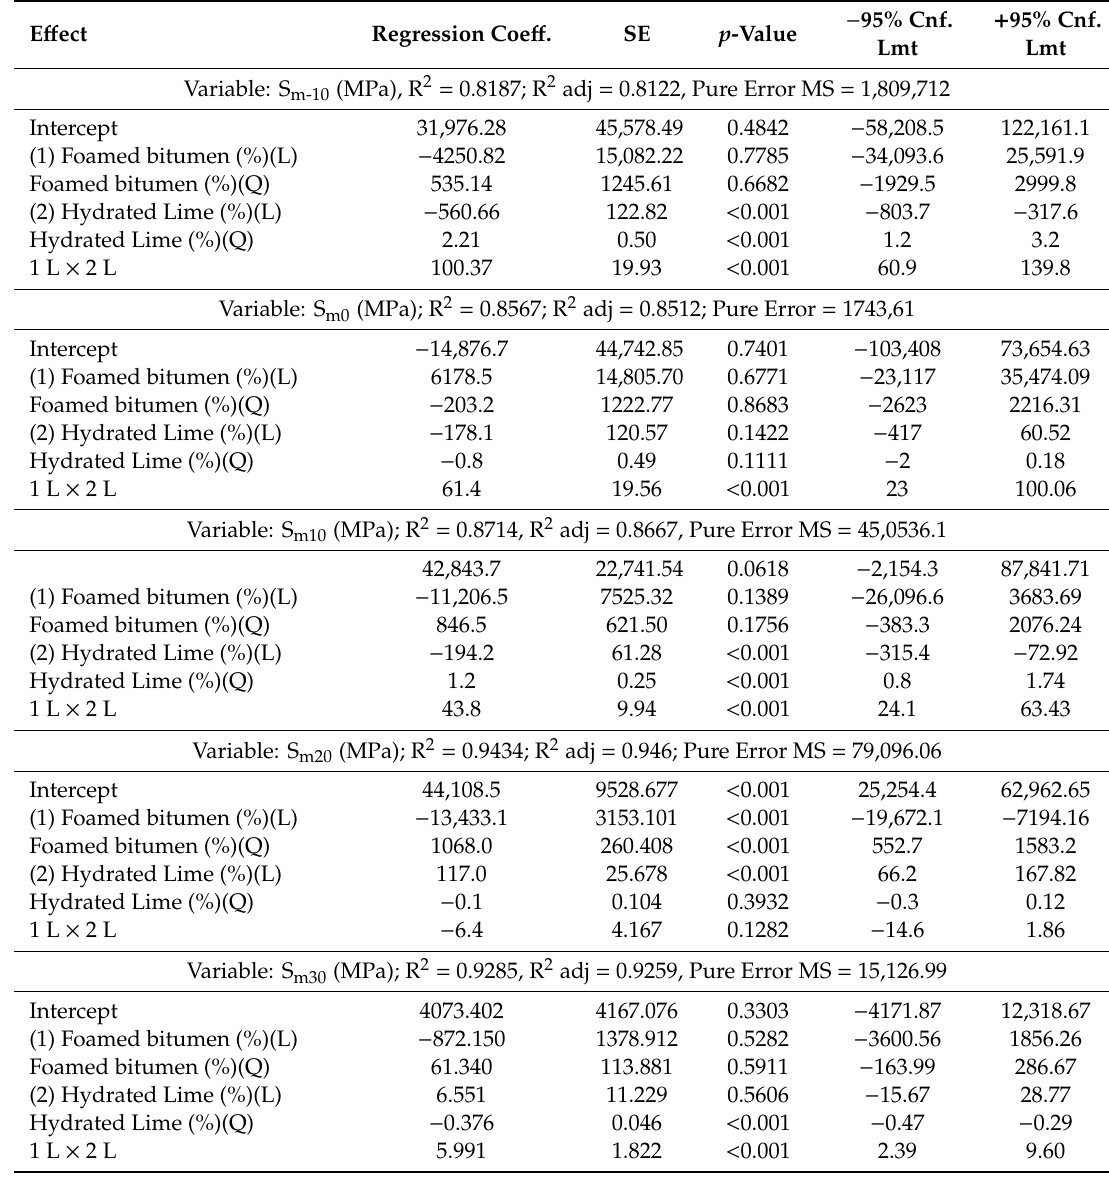
Table 6. Sti ff ness modulus (S m ) of the HWMA concrete, as a function of test temperature and the amount of foamed bitumen and hydrated